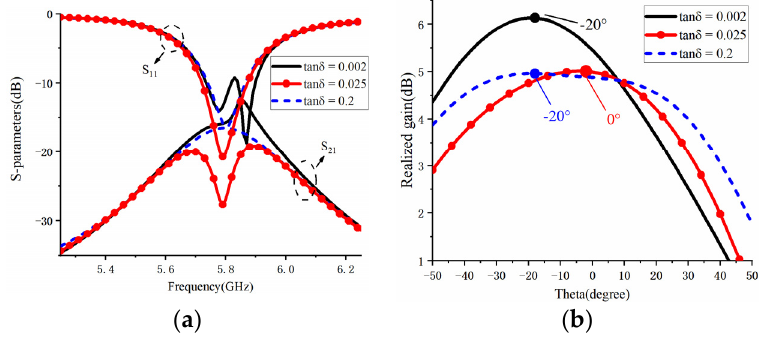
Figure 4. Wall substrate effect on antenna performance: ( a ) S-parameters and ( b ) radiation patterns and gain at 5.80 GHz.